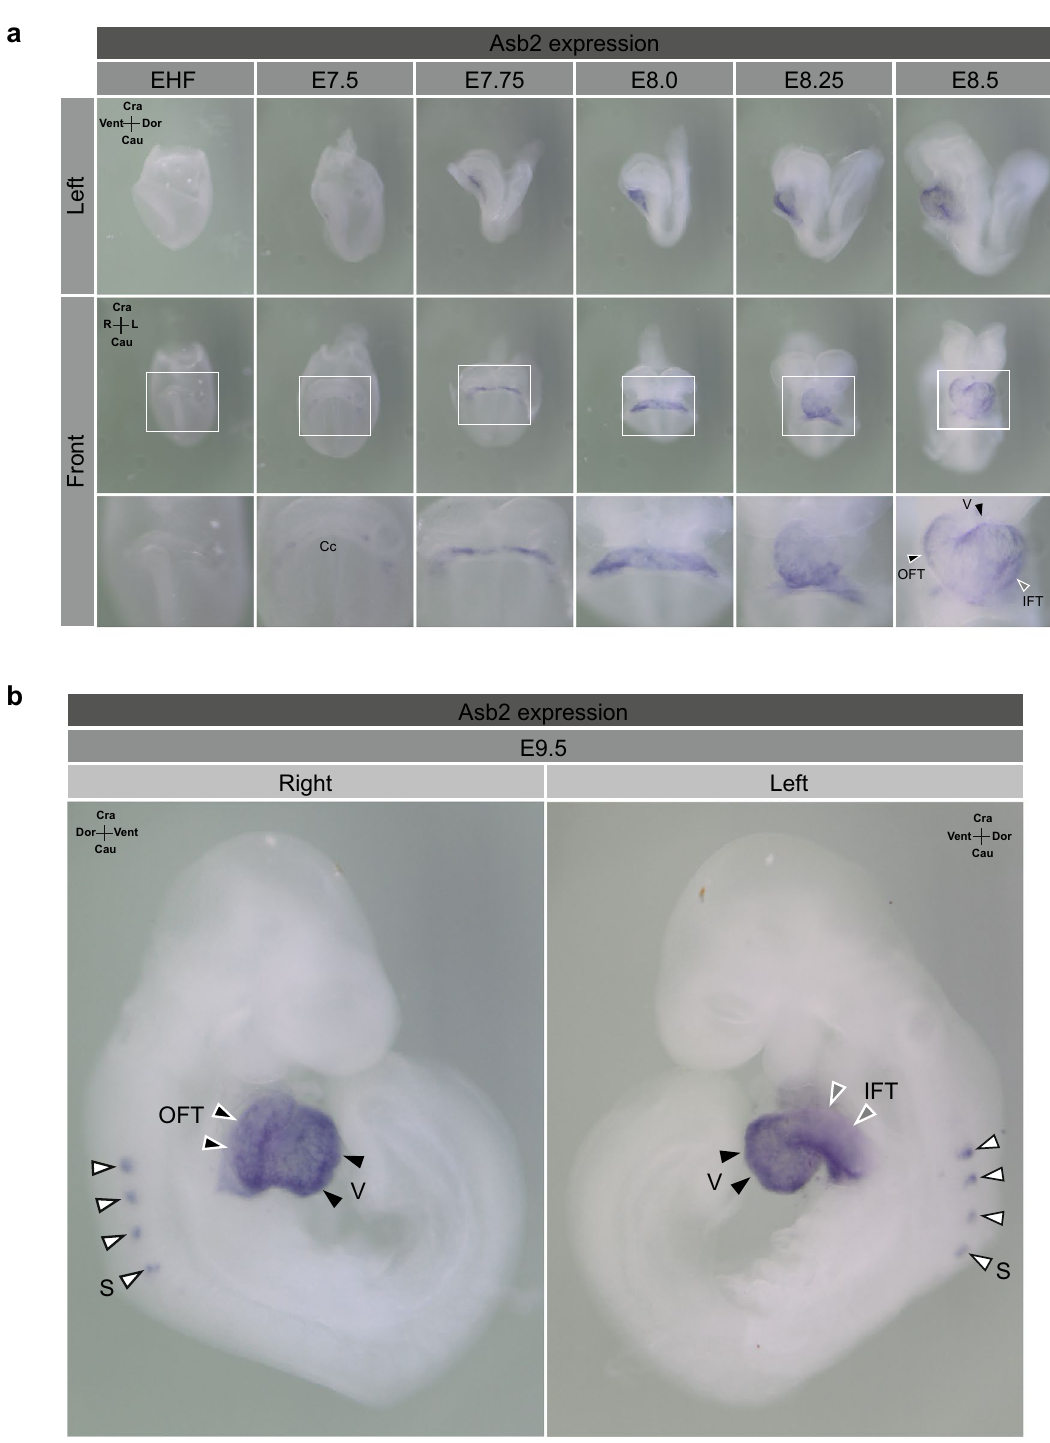
Figure 3. Asb2 is specifically expressed in the cardiac region during early embryogenesis of mice. Whole mount in situ hybridization was performed using murine embryos. ( a ) Asb 2 expression was detected in the cardiac region as early as formation of the cardiac crescent at E7.5. Thereafter, Asb 2 expression was localized at the cardiac region until cardiac formation was completed. ( b ) At E9.5, Asb2 expression was detected in the ventricular myocardium and outflow and inflow tracts. Additionally, extra-cardiac expression of Asb2 was initiated at several somites at this stage. EHF, early head fold; Cc, cardiac crescent; OFT, outflow tract; IFT, inflow tract; v, ventricle; s,